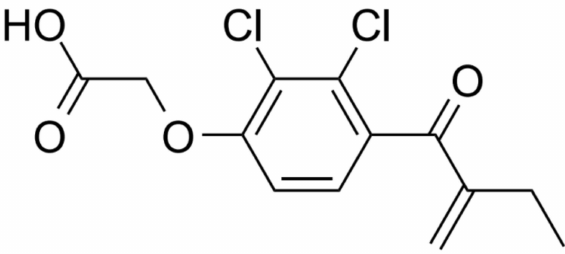
Figure 1. Chemical structures of the ethacrynic acid